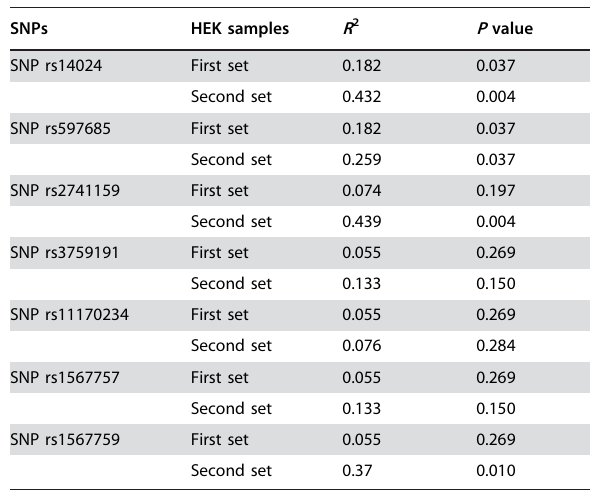
Table 2. Linear regression analysis of SNPs in the KRT1 interval